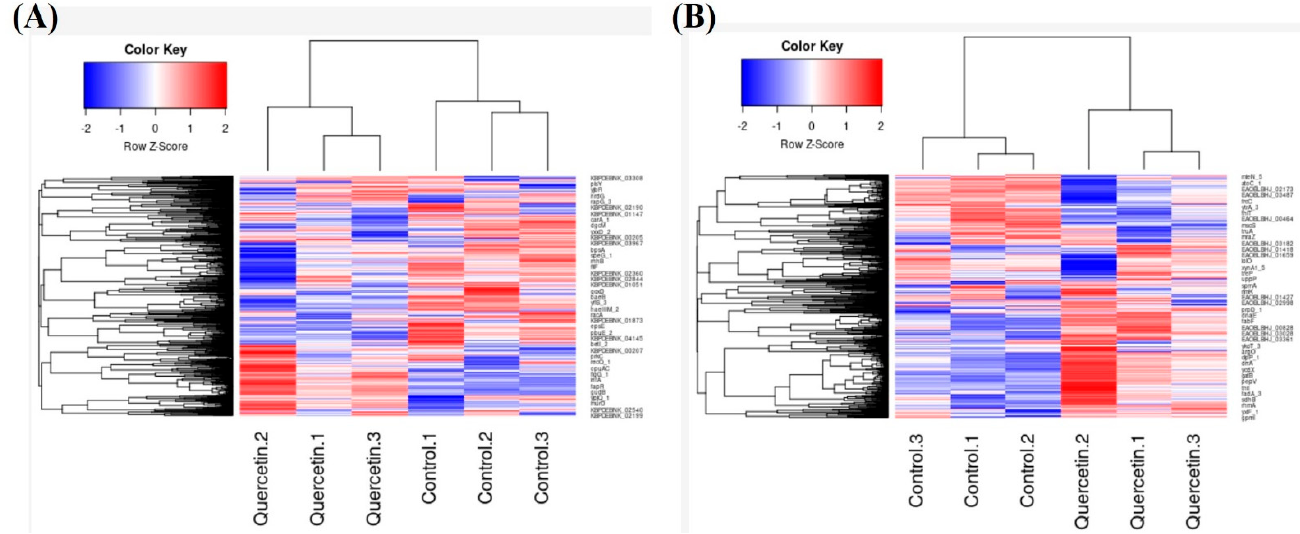
Figure 6. Hierarchical cluster heat map of differentially expressed genes in ( A ) B. glycinifermentans and ( B ) F. plautii . The figure represents the expression level of each cluster of genes for ( A ) B. glycinifermentans and ( B ) F. plautii with (QC) and without (X7N) quercetin.